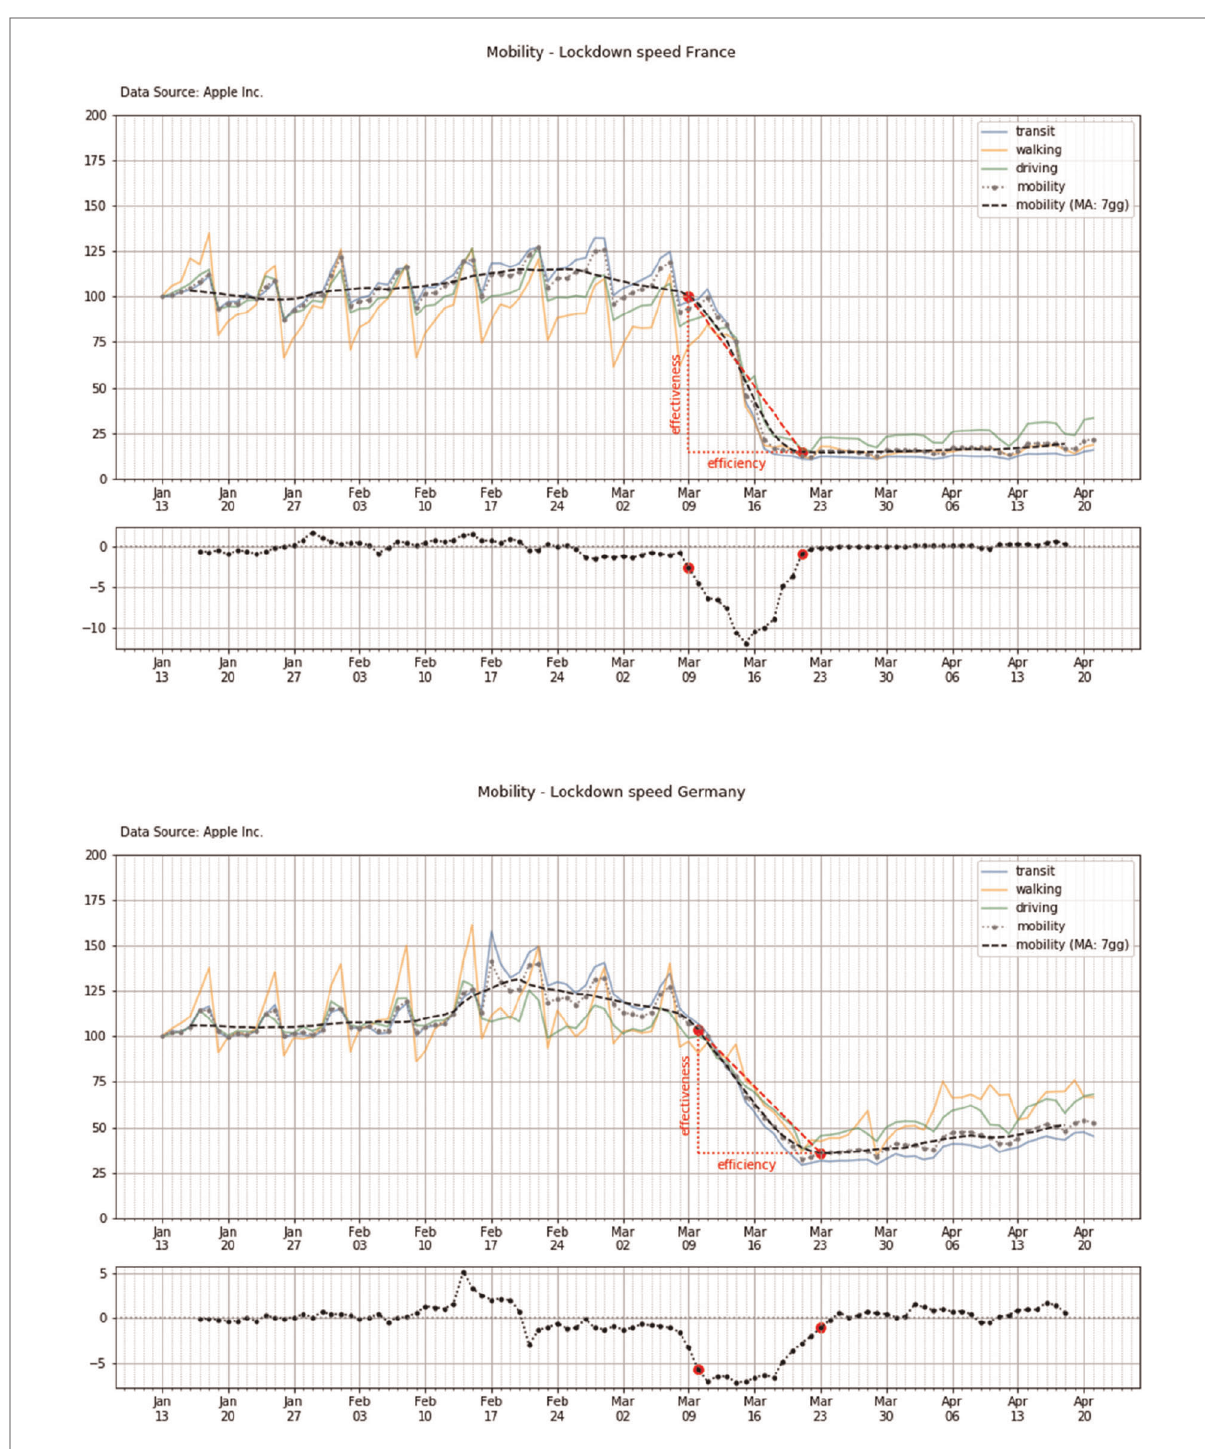
FIGURE 10 Lockdown and mobility timeline in France and Germany (top and bottom panels,